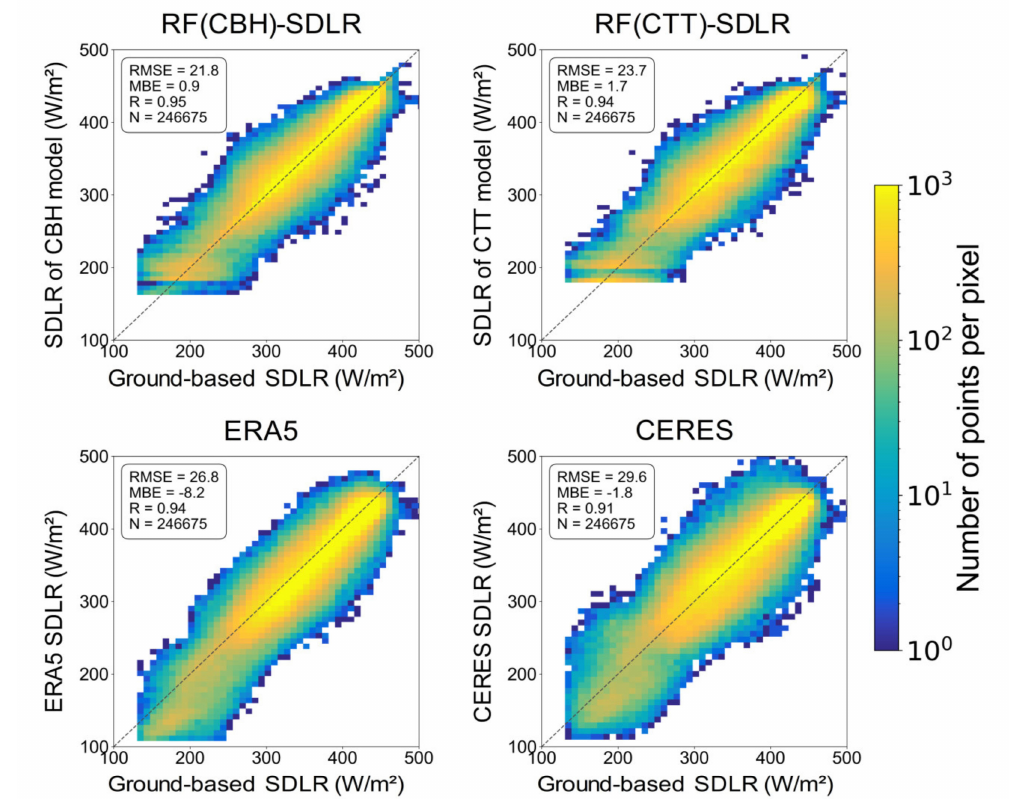
Figure 8. The validation results of RF-SDLR, the surrogated parameter algorithm, ERA5 reanalysis, and CERES against the ground